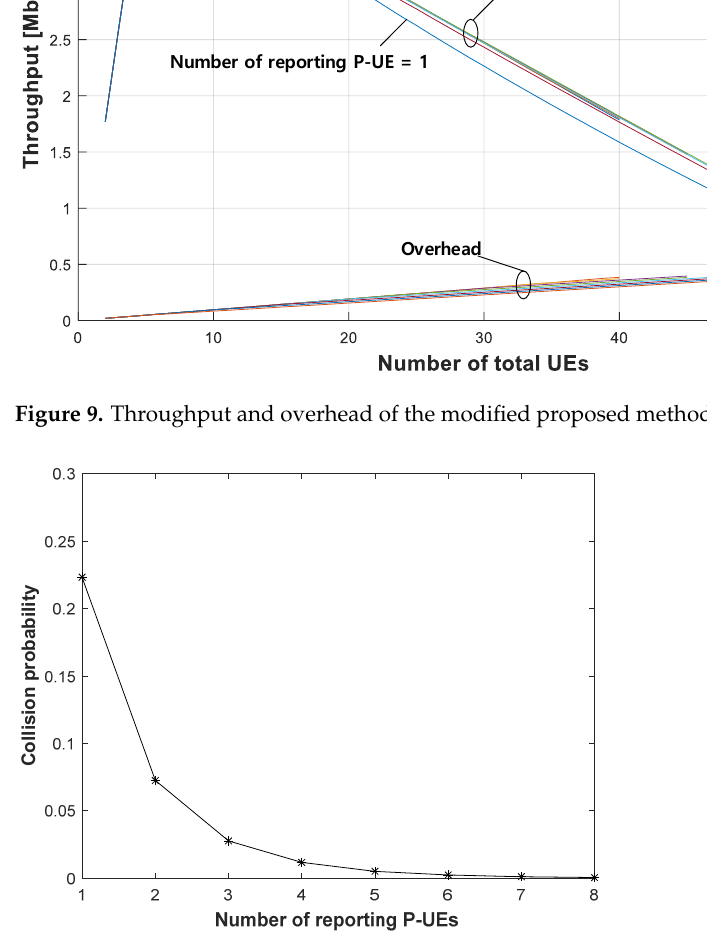
Figure 10. Collision probability.